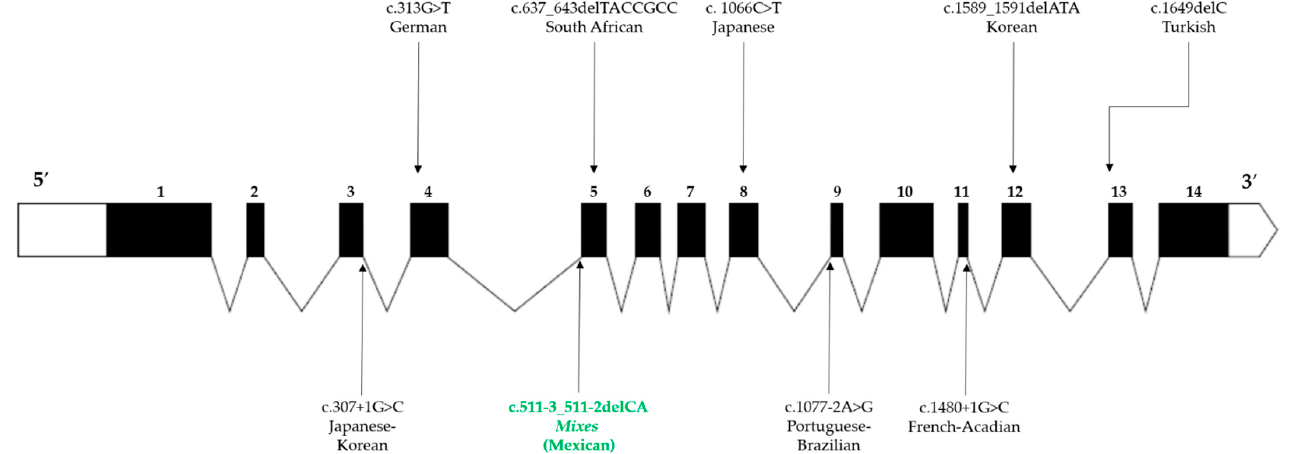
Figure 3. Worldwide founder pathogenic variants reported in FANCG . The structure of FANCG is described in 5’-3’ orientation. The untranslated regions are illustrated at the ends of the gene (white areas), the exons are represented by numbered black boxes, and the angled lines correspond to the introns. The location of the variants is indicated by vertical arrows, those located at the bottom of the figure represent splicing variants, while deletions and missense variants are located at the top. The variant described in this study is represented by green letters. Table 3. Founder pathogenic variants reported in FANCG.